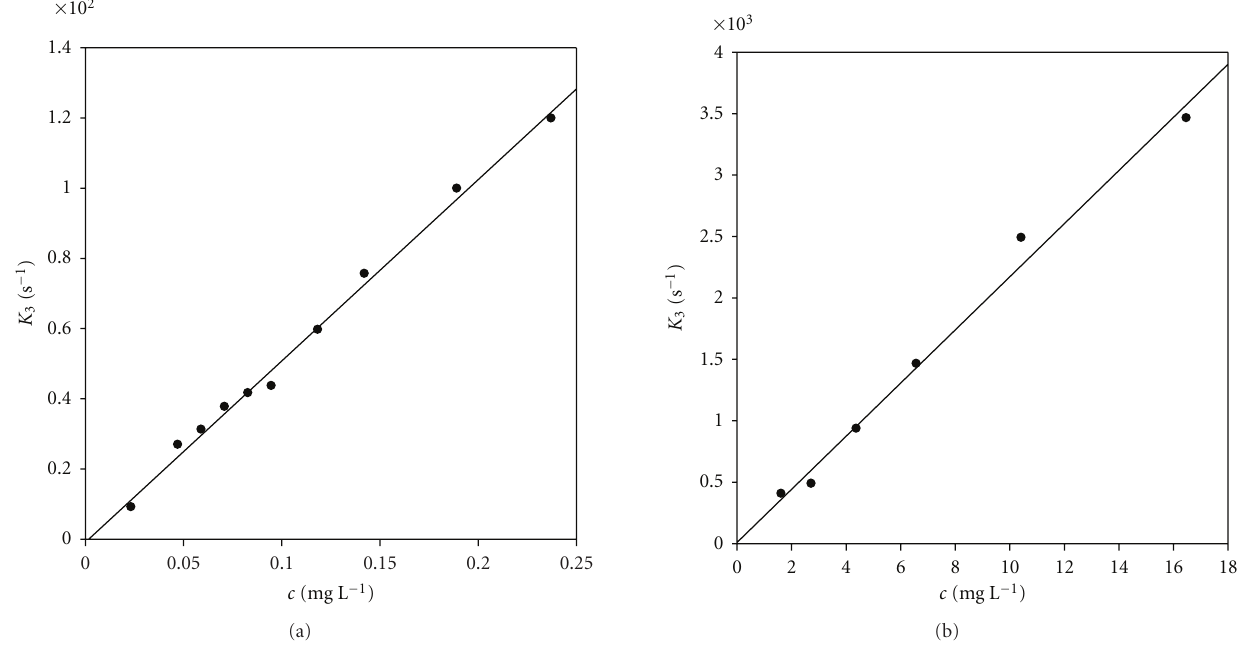
Figure 4: The calibration curves for (a) T-X-100 and (b) humic acid constructed by plotting the slopes from i ac (relative)- t lines against concentrations. All conditions as in Figures 2 and 3.